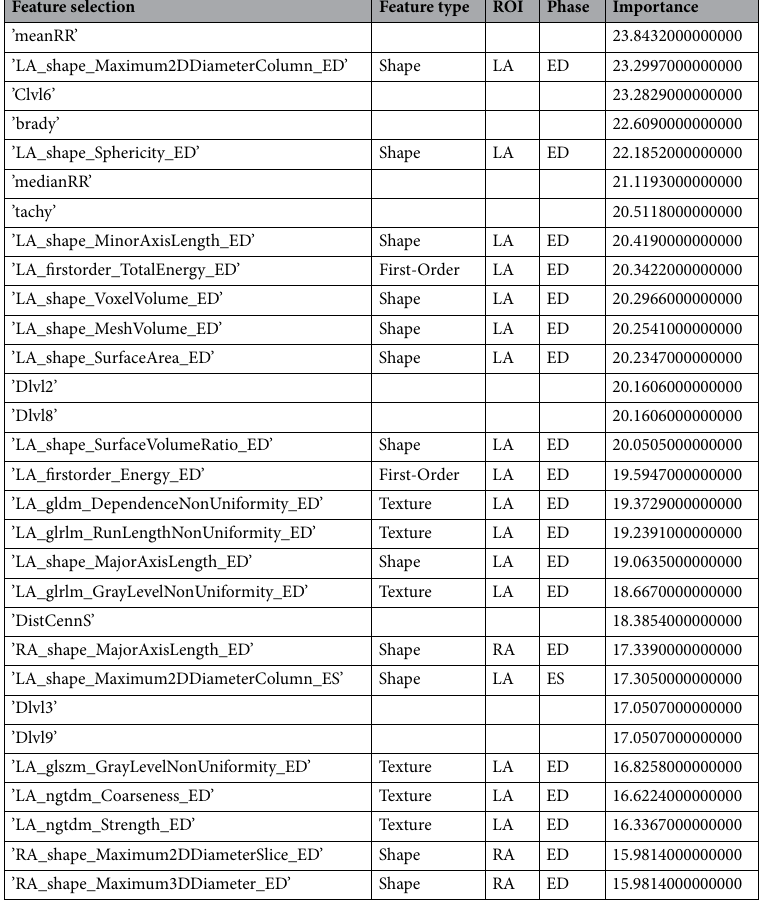
Table 3. Feature selection for AF for women for the electro-radiomics